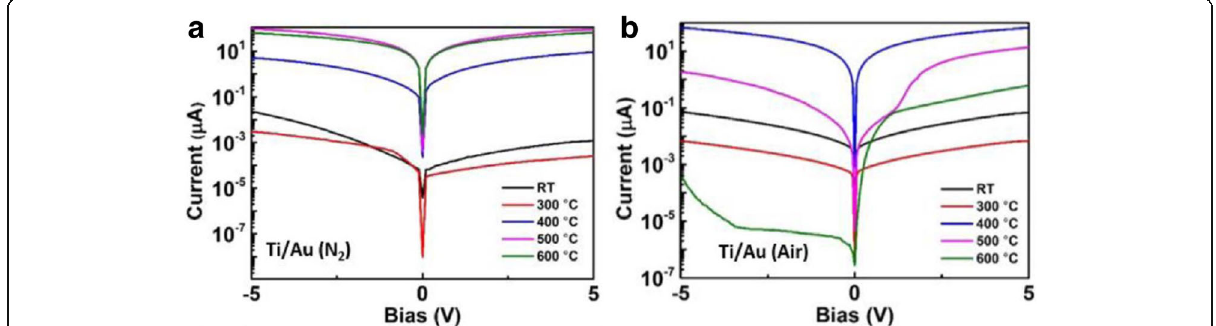
Fig. 7 Electrical properties of β -Ga 2 O 3 flakes with different thermal annealing atmosphere and annealing temperature. Ti/Au contacts under a N 2 and b air. Reproduced from Ref.